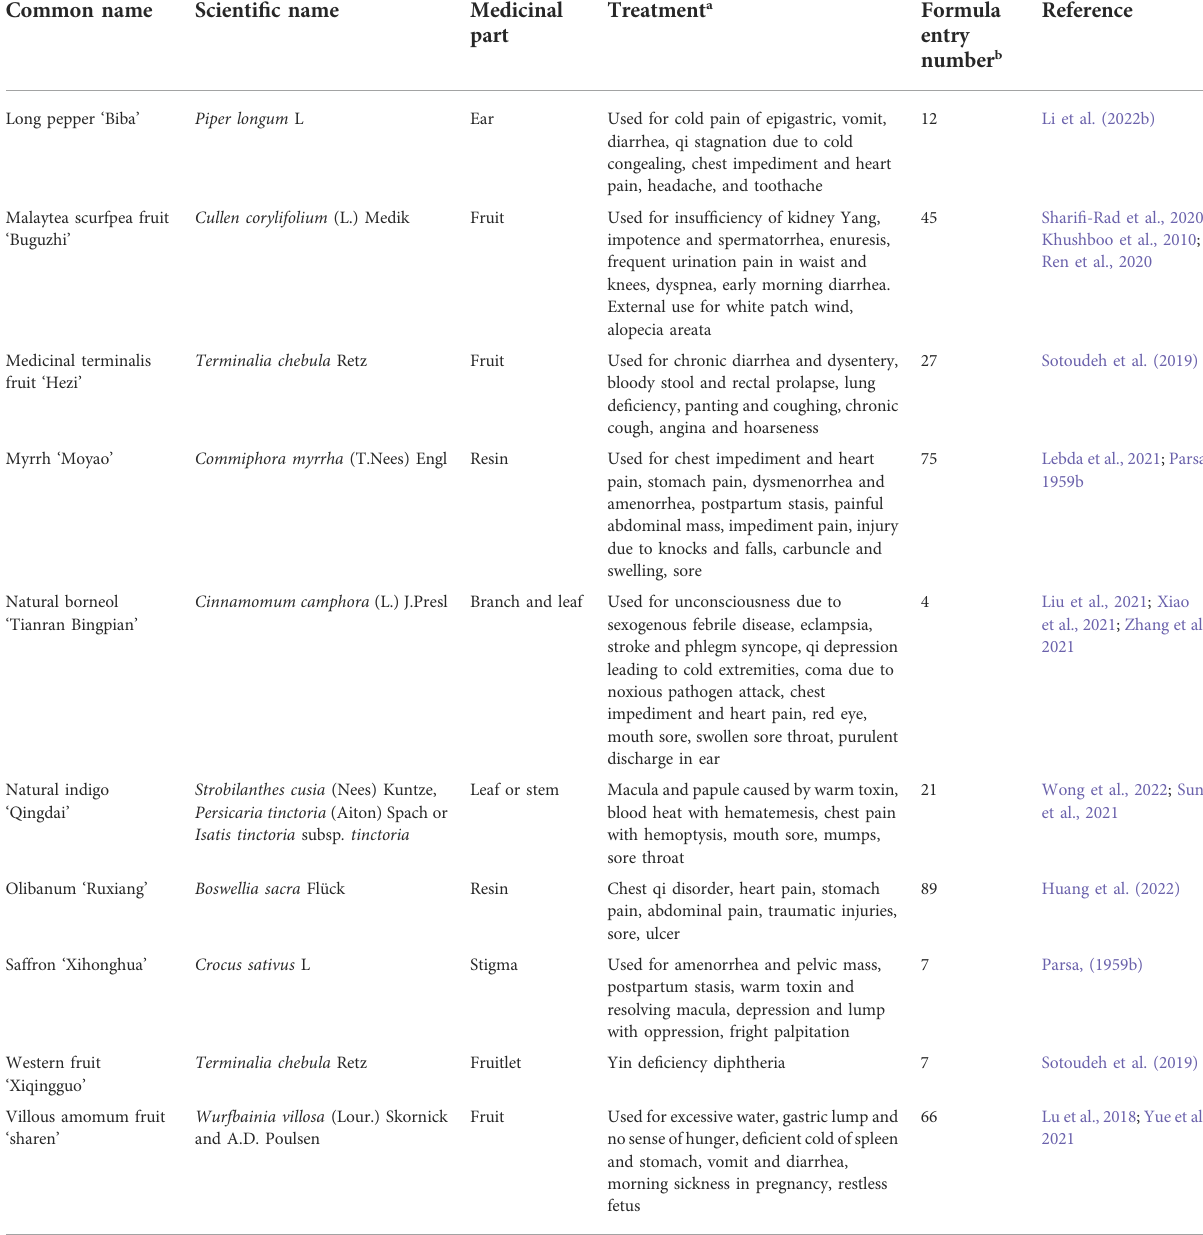
Figwort fl ower picrorhiza rhizome /